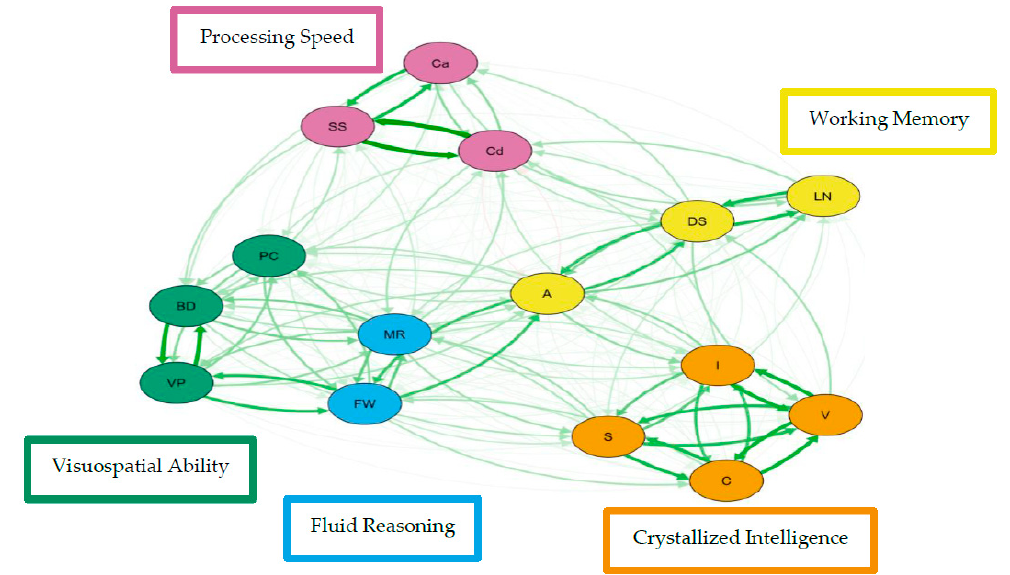
Figure 4. Weighted, directed psychometric network model of the Hungarian Wechsler Adult Intelligence Scale Fourth Edition estimated using openMx. Green edges indicate positive partial correlations and red edges indicate negative partial correlations between nodes.